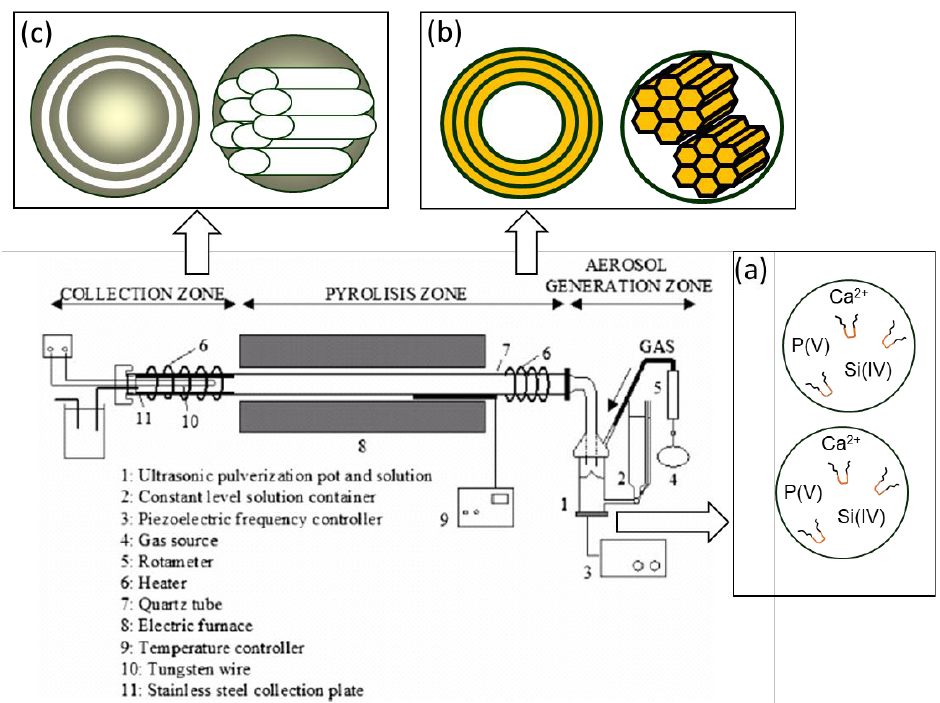
Figure 2. Scheme of an aerosol-assisted method device for the synthesis of mesoporous bioactive nanoparticles: ( a ) aerosol droplets containing surfactant molecules and inorganic precursors in the aerosol generation zone; ( b ) aerosol droplets containing hexagonal and/or lamellar self-assembled micelles at the heating zone; ( c ) mesoporous bioactive nanoparticles collected after the pyrolysis process. Additional heat treatment is required to completely remove the organic component.